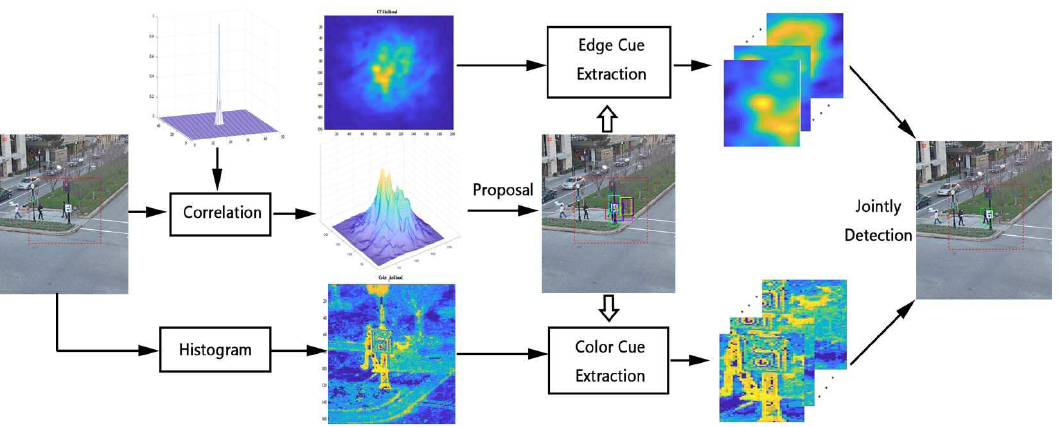
Figure 5. Architecture of the overall Region proposal correlation filter.